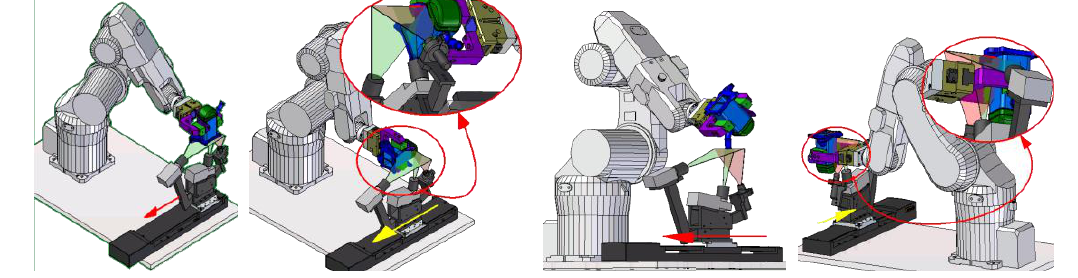
Figure 10. Positioning of the workpiece to measure each